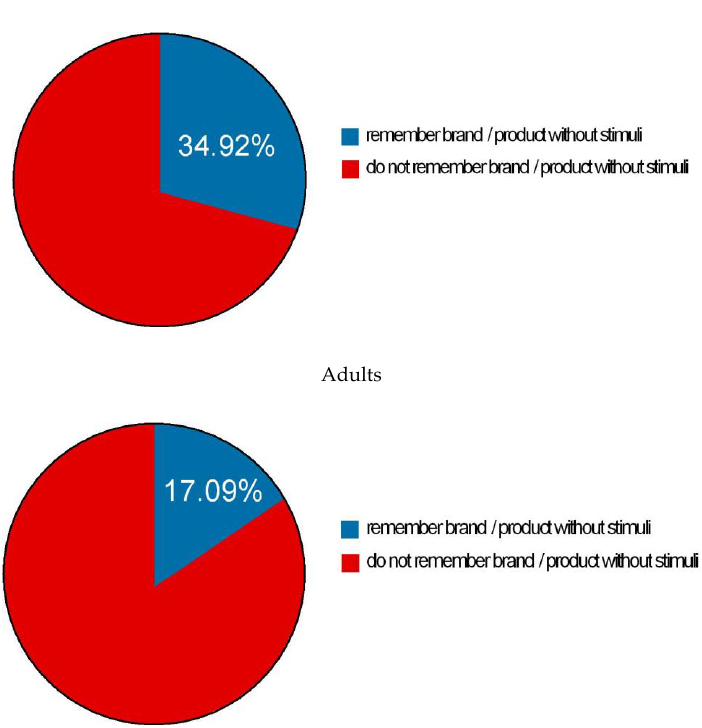
Figure 3. What product or brand do you remember watching advertised on the mobile apps you used during the last seven days?